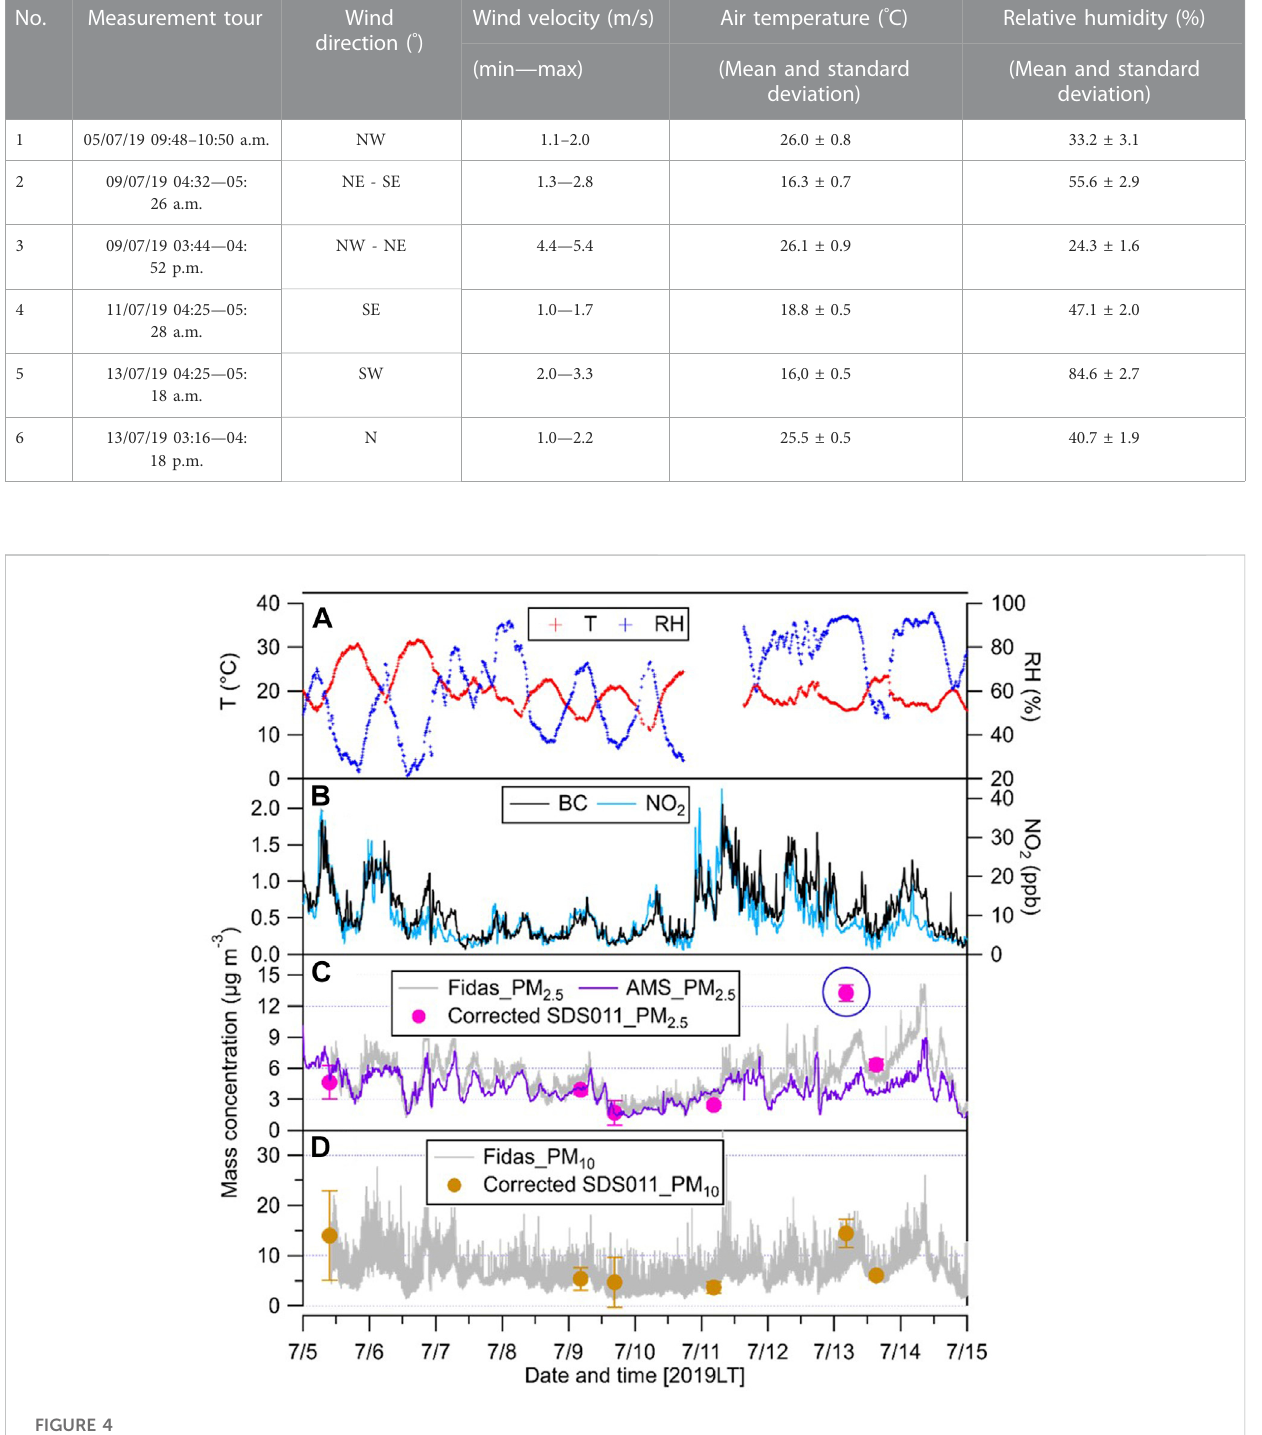
(C,D) PM 2 2.5 andPM 10 measuredby theFidas200, and